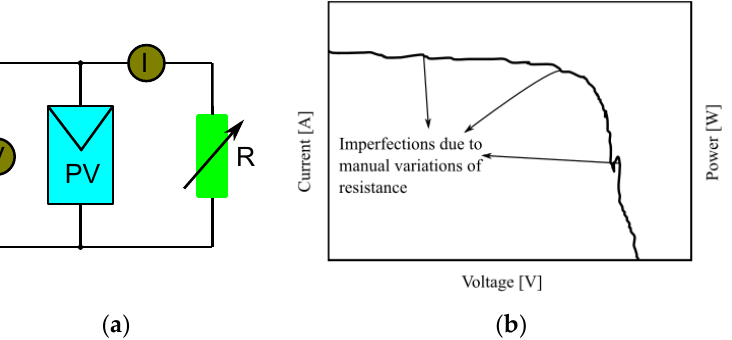
Figure 6. Schematic of a variable resistor tracer: ( a ) connection scheme. Source [16], own elaboration; ( b ) I–V curve obtained with a variable resistor tracer. Source [17], own elaboration.